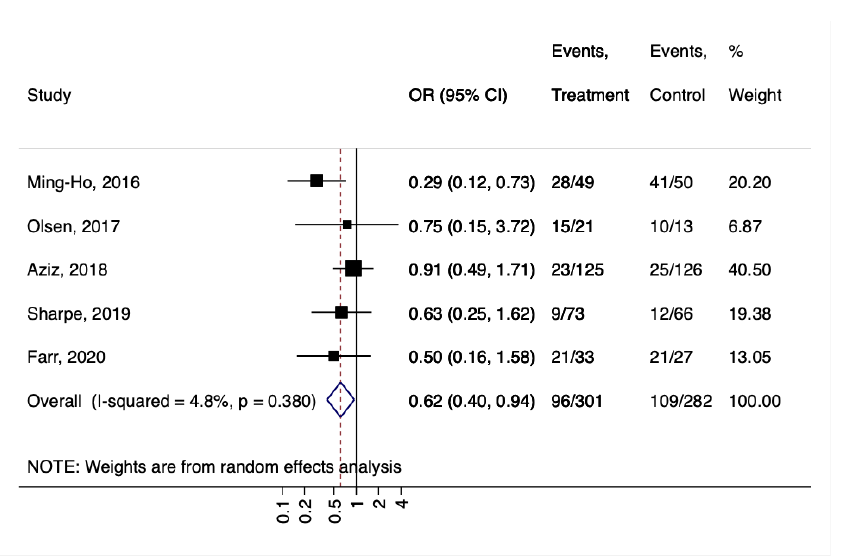
Figure 3. Forest plot for the GBS colonization. Ming-Ho, 2016 [32], Olsen, 2017 [33], Aziz, 2018 [34], Sharpe, 2019 [35], Farr, 2020 [36].